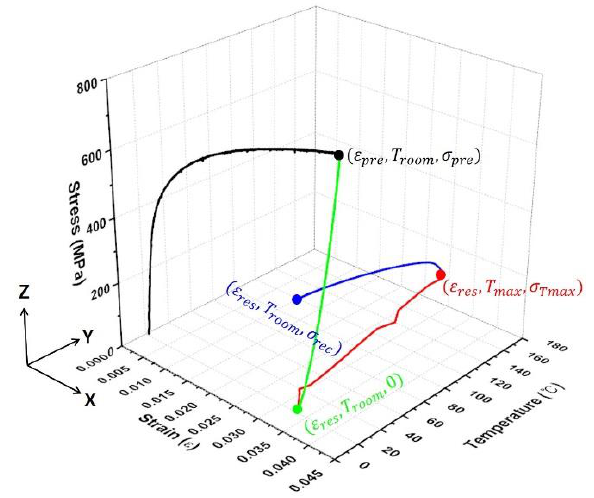
Figure 4. Strain – temperature – stress relationship of Fe-SMA rebar.